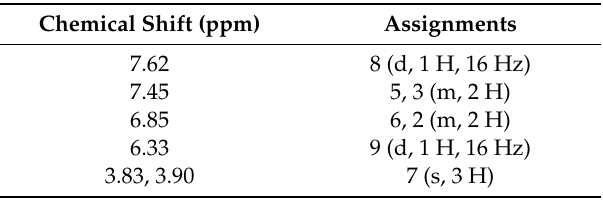
Table 3. Chemical shift, 1 H-NMR spectral data of 4-methoxycinnamic acid diester (PCO-C) with the corresponding numbering.